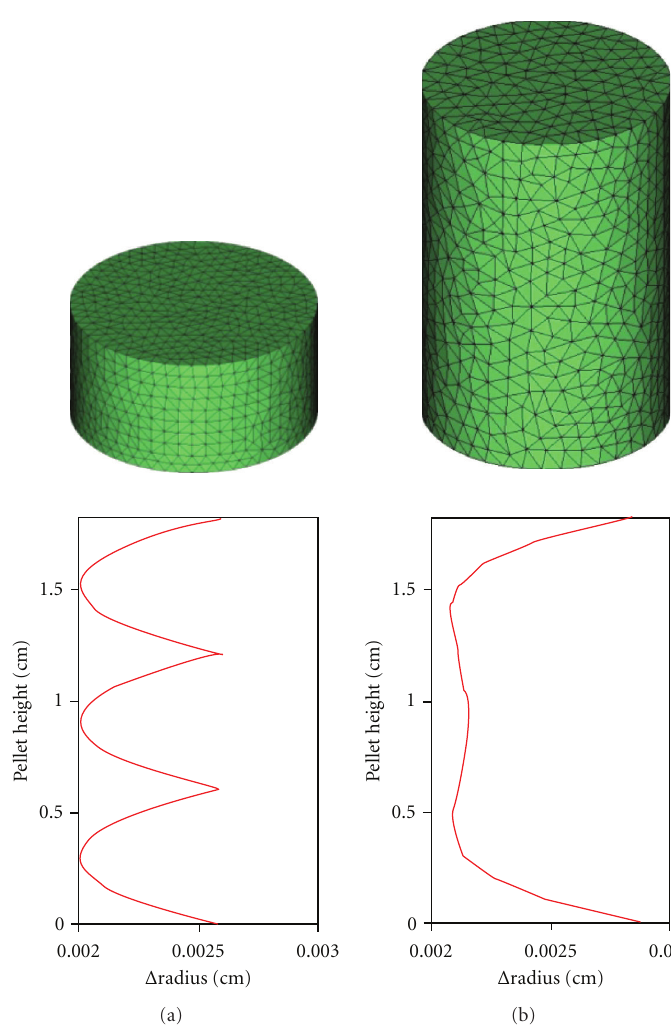
Figure 12: Meshes of CANDU pellets for the “ l/d ” analysis. (a) l/d = 0 . 5, (b) l/d = 1 . 5.